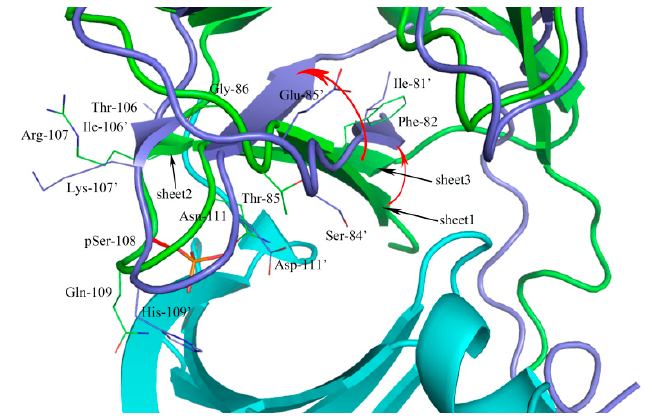
Figure 3. Structural comparison of the scope within 5 Å of the active site from β 1 and β 2 subunits. The α subunit was shown in cartoon and colored by the cyan. The β 1 and β 2 subunits were shown in cartoon and colored by green and blue, respectively. The sites with different amino acids were shown in line. The Ser-108 was shown in stick and colored by red.